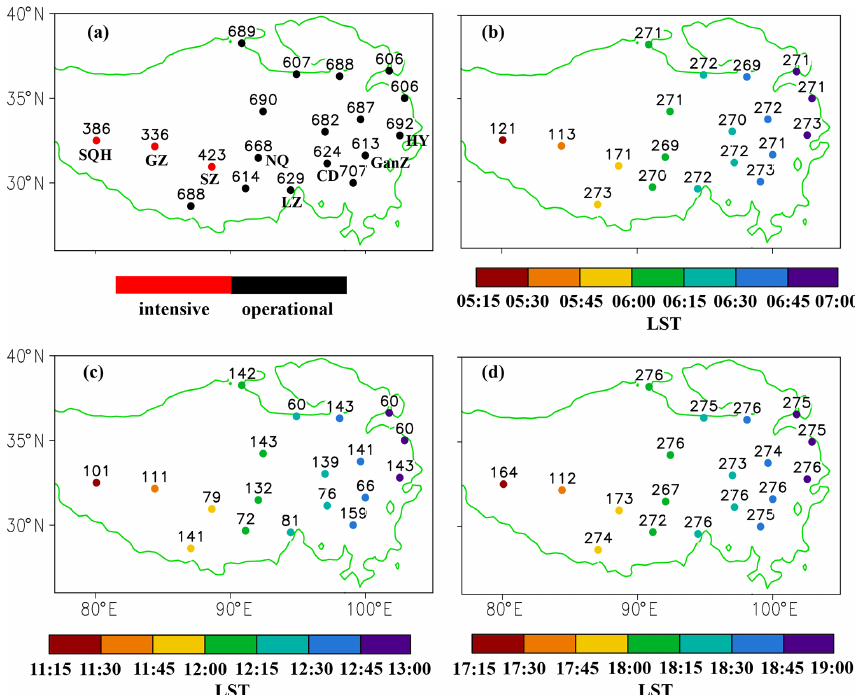
Figure 1. Distribution of sounding stations, in which the number indicates sounding profiles at each station at (a) 08:00, 14:00, and 20:00BJT; (b) 08:00BJT; (c) 14:00BJT; and (d) 20:00BJT in the study period. Red (black) dots represent intensive (operational) observations, and some observation station names are given as abbreviations in (a) . Coloured dots represent the local time of the BJT time in (b) , (c) , and (d) . The green line shows the 3000m